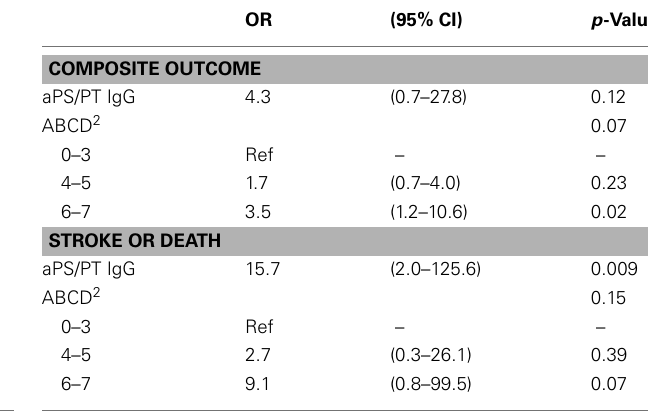
Table 3 | Multivariable models, aPS/PT IgG positivity > 30 units.